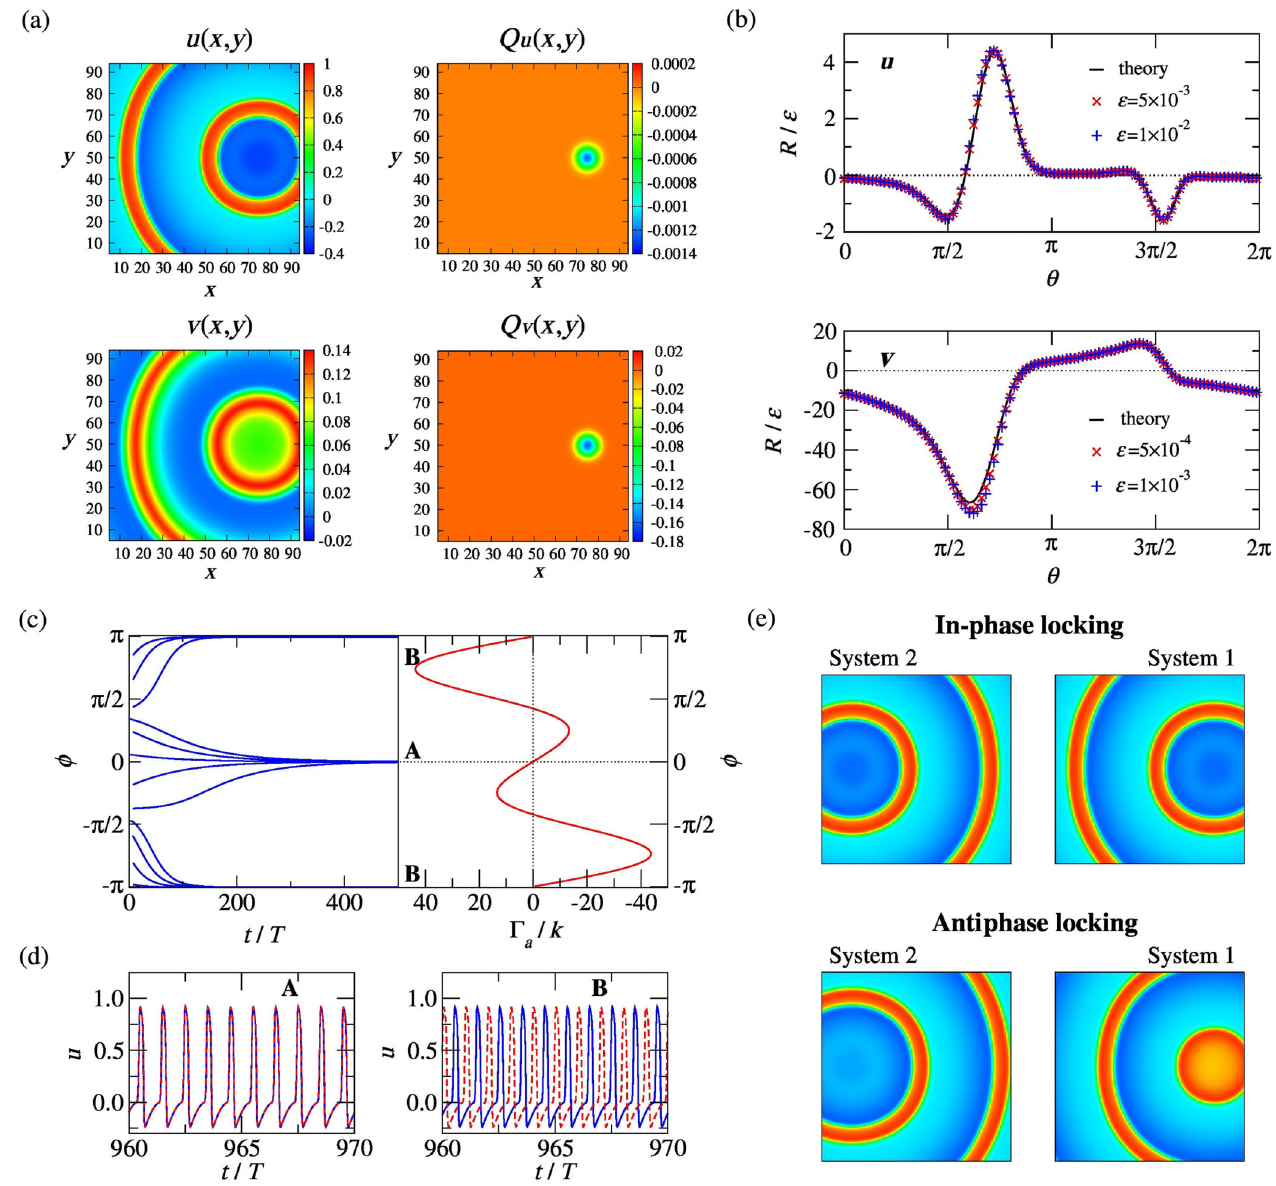
FIG. 3. Target waves. The system is a 2D square of side L ¼ 100 with no-flux boundary conditions. To create a pacemaker region, the parameter α is assumed to possess localized circular heterogeneity, i.e., α ð x; y Þ ¼ α 0 þ ð α 1 − α 0 Þ exp ð − r 4 =r 4 0 Þ , where r ¼ ½ð x − x 0 Þ 2 þ ð y − y 0 Þ 2 (cid:1) 1 = 2 is the distance from the pacemaker center at ð x 0 ; y 0 Þ and r 0 is the radius of the pacemaker region, so α ð x; y Þ → α 1 as r → 0 and α ð x; y Þ → α 0 as r → ∞ . The parameters are α 0 ¼ 0 . 1 , α 1 ¼ − 0 . 1 , r 0 ¼ 10 , and ð x 0 ; y 0 Þ ¼ ð 80 ; 50 Þ . With these values, the system is self-oscillatory near the pacemaker center and is excitable otherwise. Other parameters are τ − 1 ¼ 0 . 005 , γ ¼ 2 . 5 , κ ¼ 0 . 15 , and δ ¼ 0 . The temporal oscillation period is T ¼ 205 . 4 . (a) Target-wave solution X 0 ð x; y Þ ¼ ½ u ð x; y Þ ; v ð x; y Þ(cid:1) and the corresponding phase- sensitivity function Q ð x; y Þ ¼ ½ Q u ð x; y Þ ; Q v ð x; y Þ(cid:1) at θ ¼ 0 (see Appendix C for other values of θ ). (b) Phase-response curves R ð θ Þ of the target wave normalized by the stimulus intensity ε . Sinusoidal perturbation s ð x; y Þ ¼ ε cos ð 4 π x= 100 Þ cos ð 4 π y= 100 Þ is given either to the activator ( u ) or inhibitor ( v ) component. Results obtained by direct numerical simulations with two different values of ε are compared with the theory, R ð θ Þ ¼ h Q ð x; y ; θ Þ ; s ð x; y Þi , where the inner product is taken over the 2D square ( 0 ≤ x , y ≤ L ). (c) Evolution of phase differences between two systems coupled through the u component with the intensity matrix K ¼ diag ð k ¼ 5 × 10 − 4 ; 0 Þ , compared with the antisymmetric part of the phase-coupling function Γ a ð ϕ Þ (rescaled by the coupling intensity k ). Different blue lines show the evolution of ϕ for different initial conditions. Both in-phase (A) and antiphase (B) synchronization can occur, depending on the initial conditions. (d) Evolution of the activator u measured at the center ½ð x; y Þ ¼ ð L= 2 ; L= 2 Þ(cid:1) of systems 1 and 2 in the in-phase (A) and antiphase (B) synchronized states. The solid line corresponds to system 1, and the dashed line corresponds to system 2. (e) Snapshots of the activator patterns u ð x; y Þ of both systems in the in-phase (A) and antiphase (B) synchronized